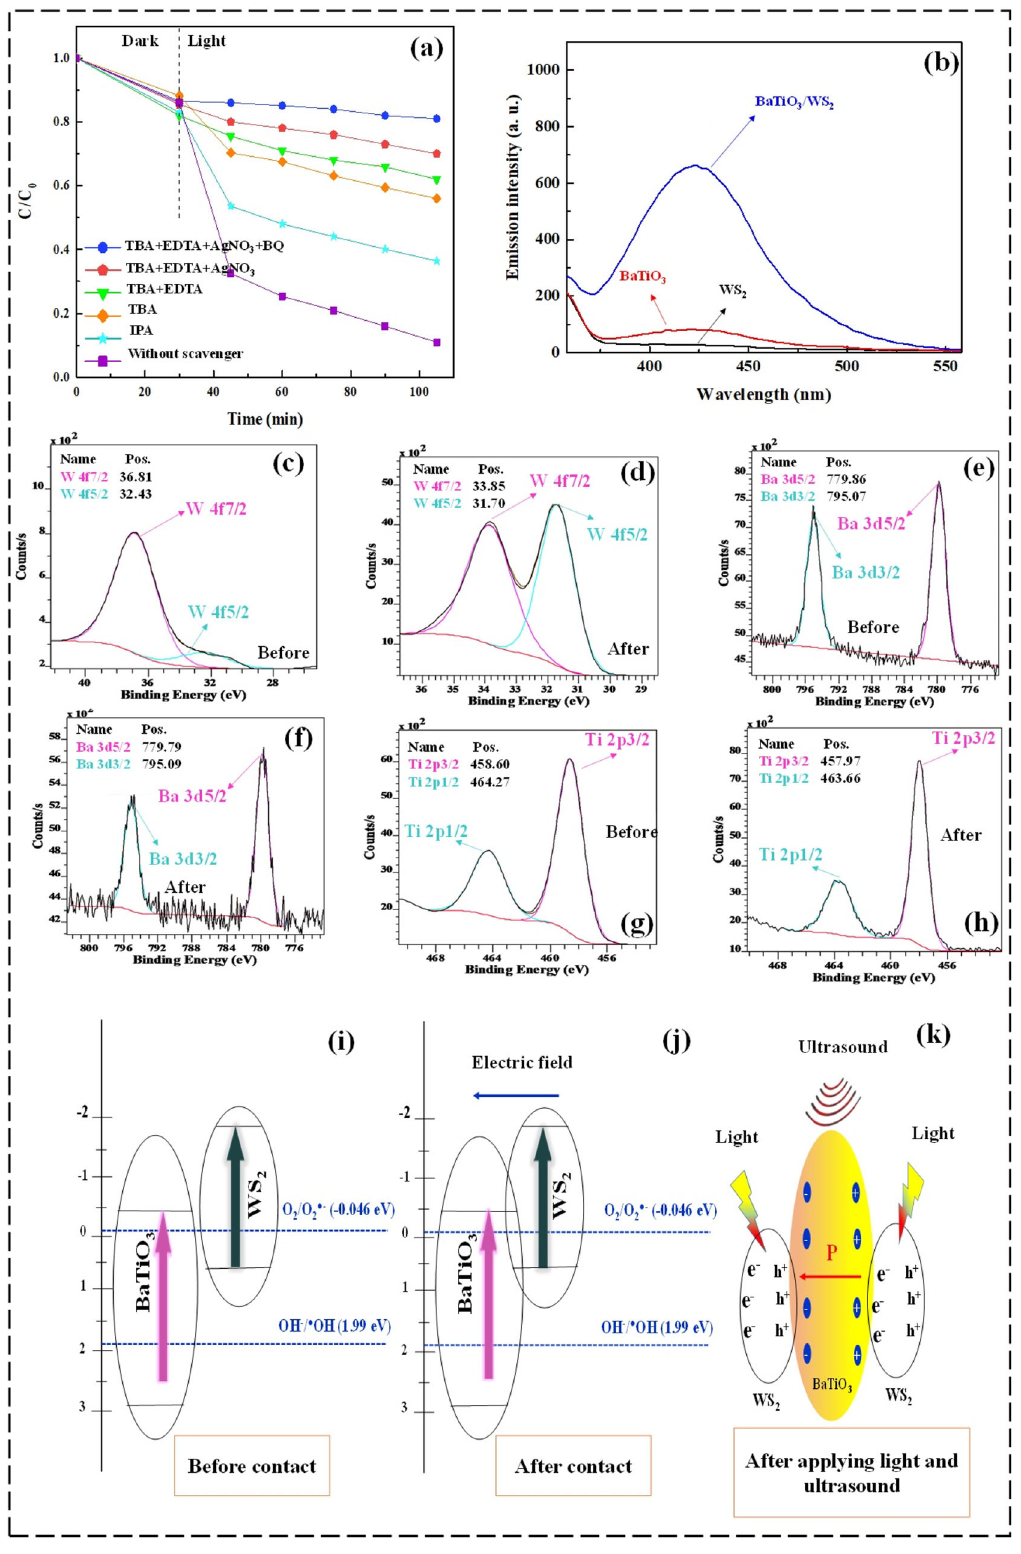
Fig. 7 Evaluating the produced ROSs and piezo-photocatalytic mechanism. a The effect of diverse scavengers on the piezo-photocatalytic degradation of OFL in the presence of PS, b Fluorescence spectra of the materials in the presence of AgNO 3 , c – h high-resolution XPS spectra of W, Ba, and Ti before and after contact of WS 2 and BaTiO 3 , and i – k the proposed schematic mechanism for the charge-carrier transference of the BaTiO 3 /WS 2 composite. Experimental condition: Catalyst concentration = 1.0 g L − 1 , [OFL] = 20 mg L − 1 , pH = 6.5, [Scavengers] = 5 mmol L − 1 . The error bars were not shown, as they were smaller than the data